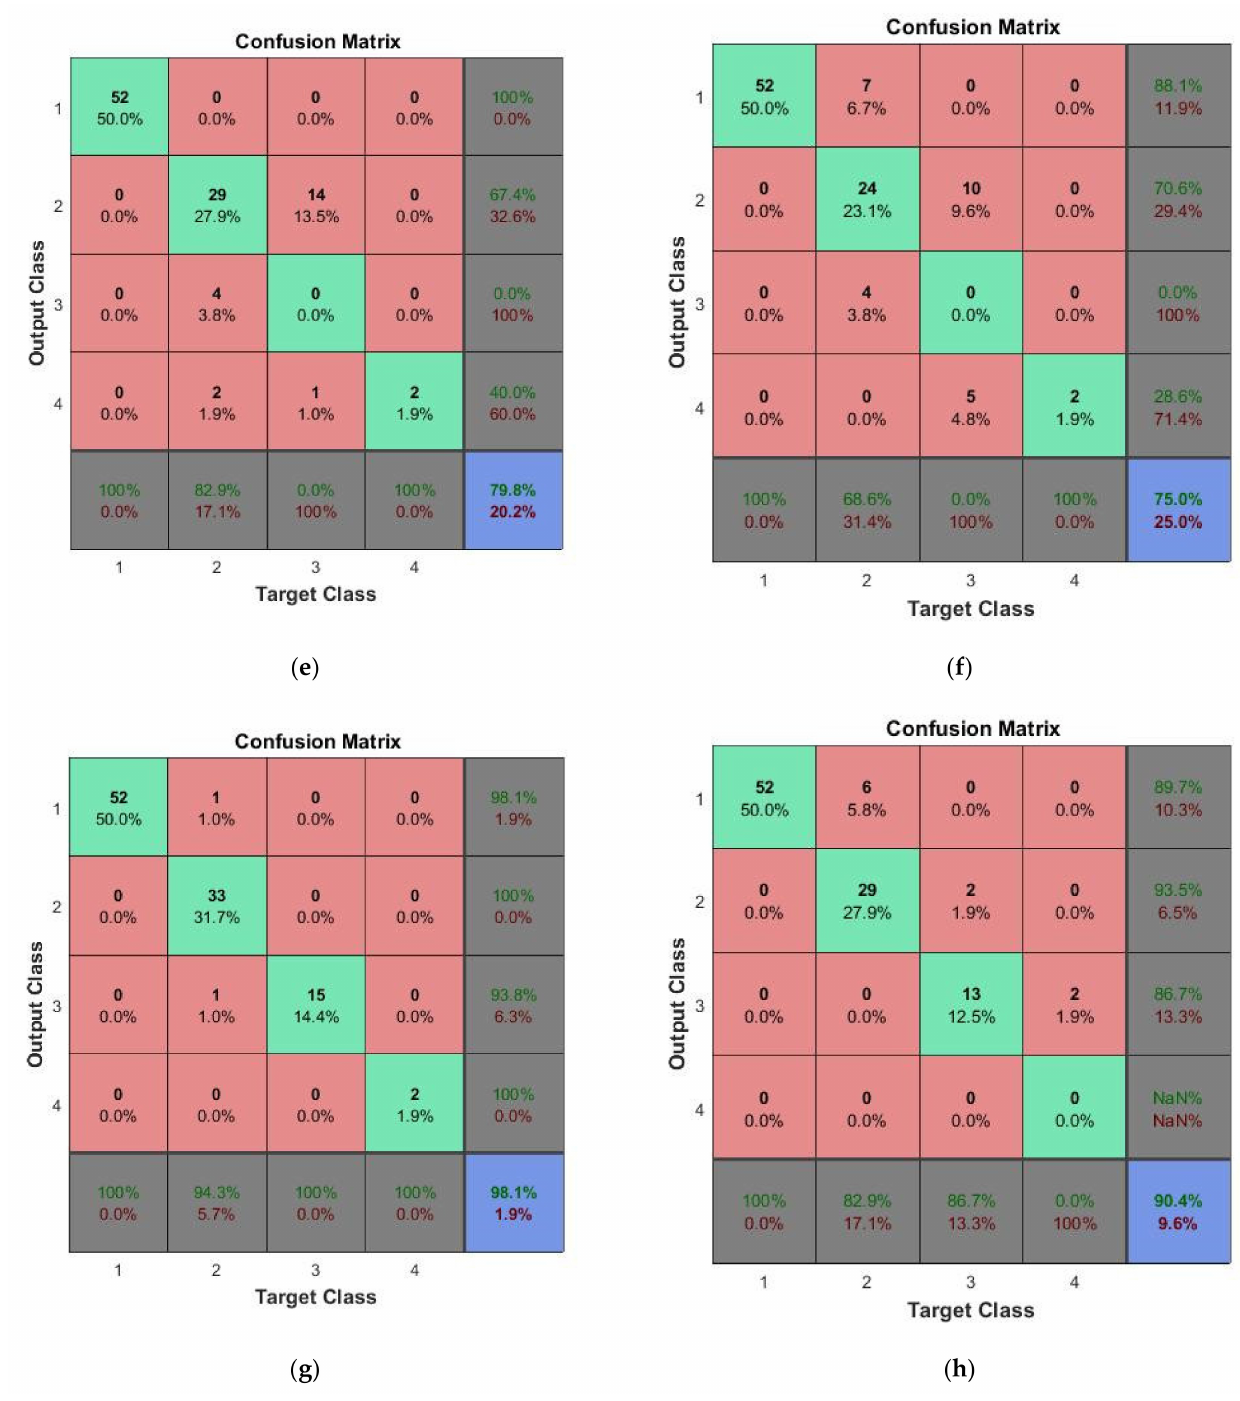
Figure 6. This figure represents the confusion matrix for the first experiment using ( a ) only linear SVM, ( b ) only kernel SVM, ( c ) only PCA feature extraction and linear SVM, ( d ) only PCA feature extraction and kernel SVM, ( e ) only LDA feature extraction and linear SVM, ( f ) only LDA feature extraction and kernel SVM, ( g ) hybrid feature extraction and linear SVM, and (h) hybrid feature extraction and kernel